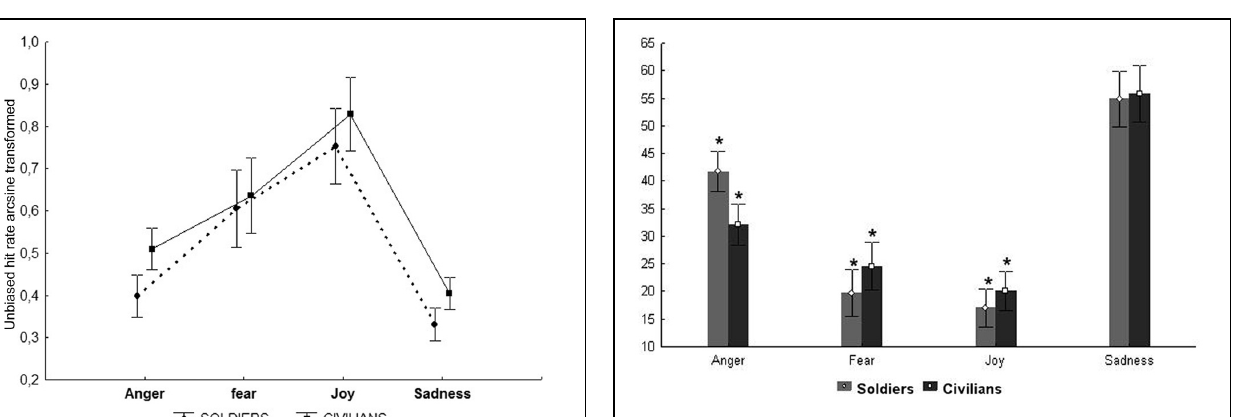
the accuracy score was different for each emotion (all p s < 0 . 005).